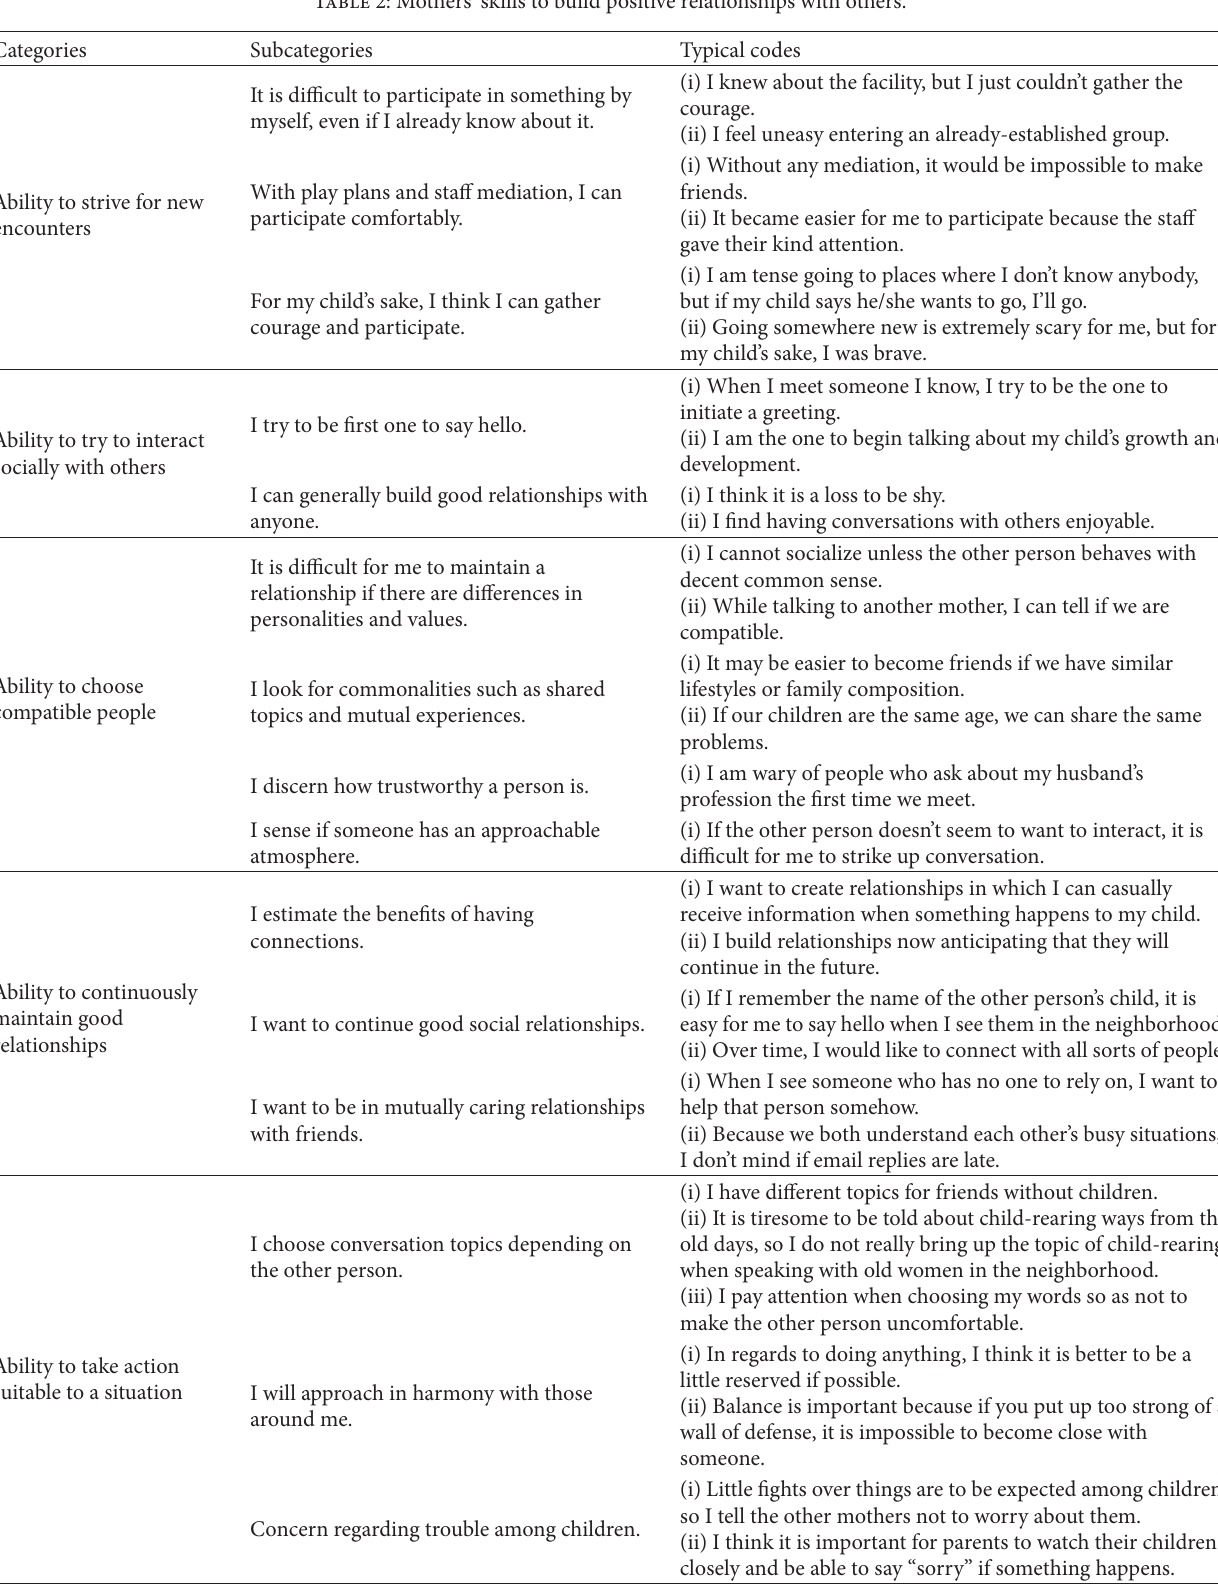
Table 2: Mothers’ skills to build positive relationships with